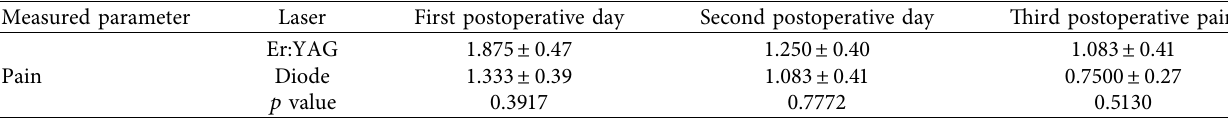
Table 8: Postoperative pain of Er:YAG compared to diode lasers.